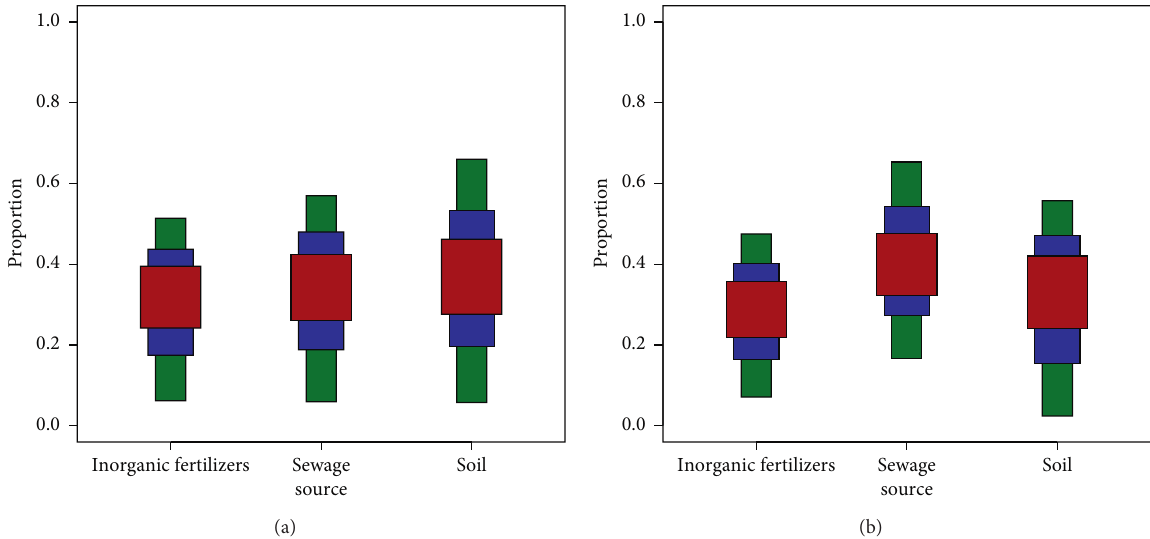
Sewage SoilInorganic source Figure 5: Box plots of mean probability estimates of the source contributions in the upstream of Fenhe Reservoir: (a) wet period; (b) dry period. Note: the legends of green, blue, and red referred to 50%, 75%, and 95% credibility interval,